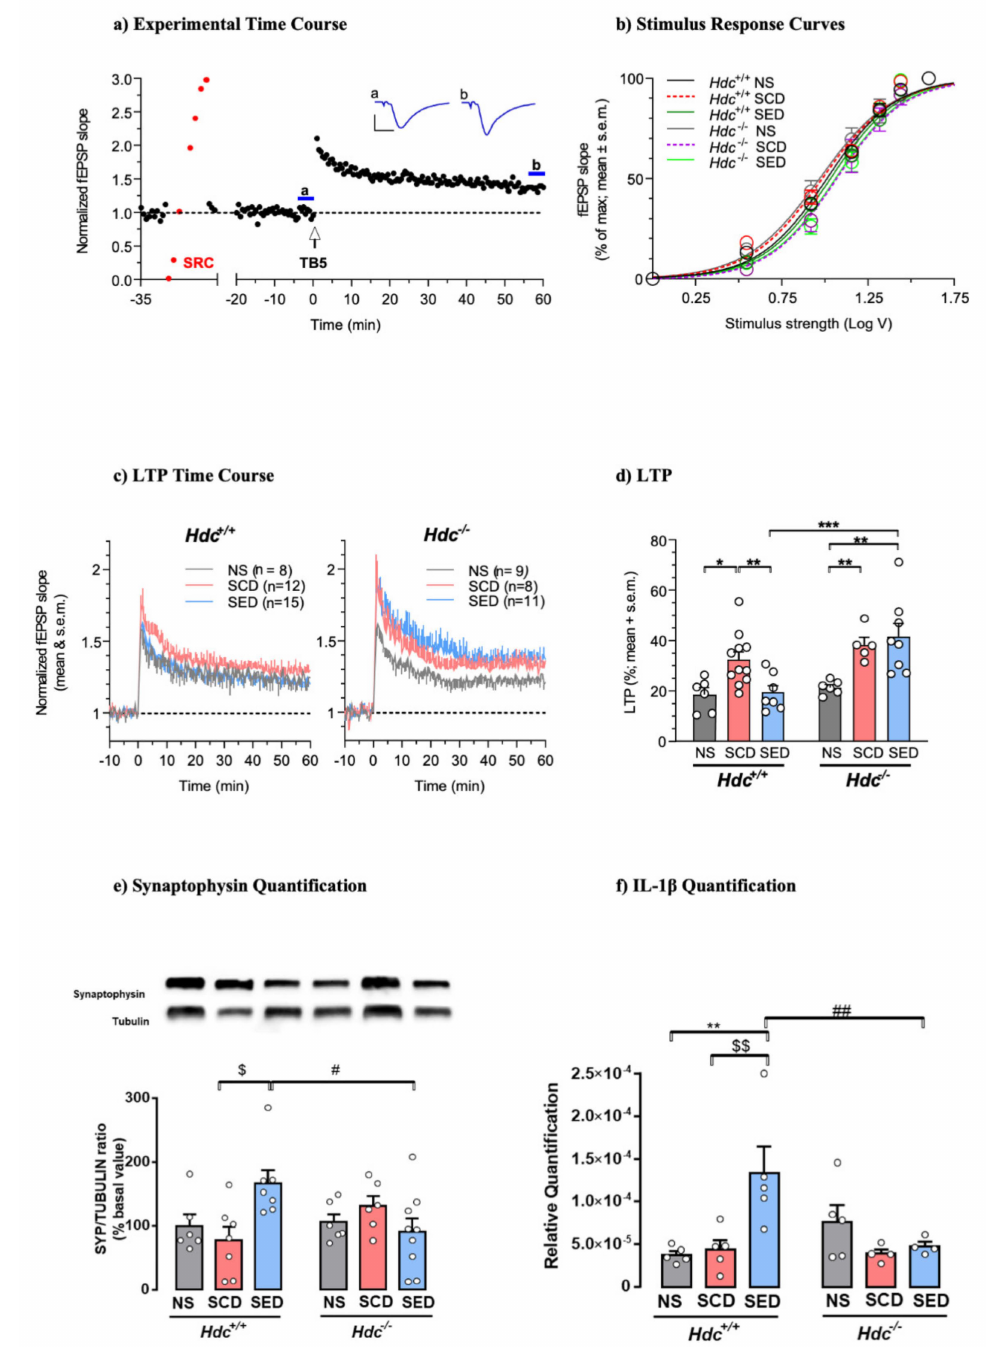
Figure 2. ( a ) Histamine deficiency prevents n-3 PUFA and Vitamin A enriched diet modulation of synaptic plasticity in dorsal hippocampal CA1 region. ( a ) Time-course of a typical experiment. Left: stimulus–response curve (SRC; red points) used to set the stimulus strength to obtain a baseline fEPSP ~35% of maximal response. Right: effect of theta burst stimulation (TB5, arrow). Symbols represent fEPSP slope values normalised to the mean of baseline values measured from 20 to 0 min before TB5. Inset: traces are the average of 7 responses obtained at times indicated by corresponding letters in the time-course (blue lines). Calibration: 1 mV, 5 ms. ( b ) SRCs at baseline were similar across genotypes and treatments. Lines are the best least-squares fit to the logistic equation